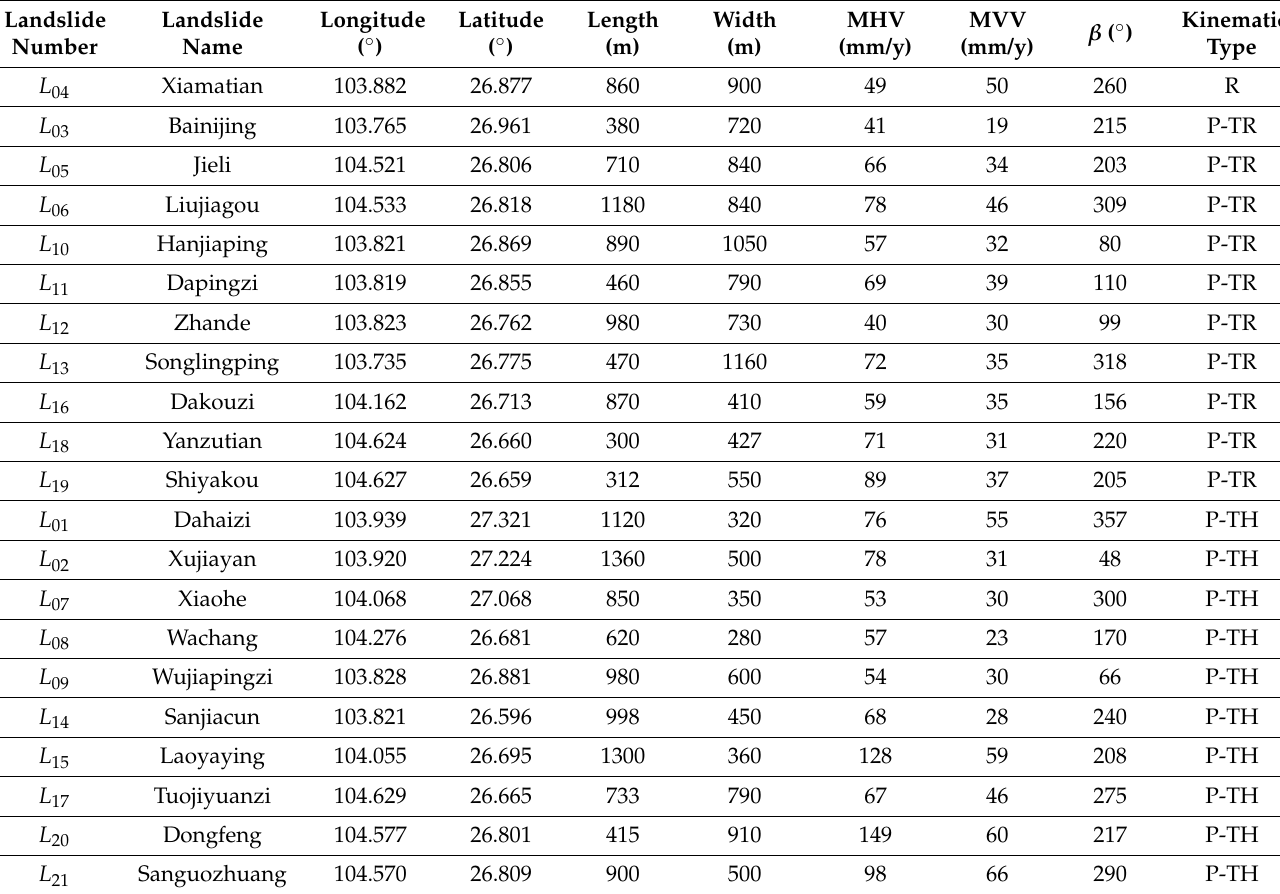
Table 2. Characteristics of active landslides detected by InSAR in the study